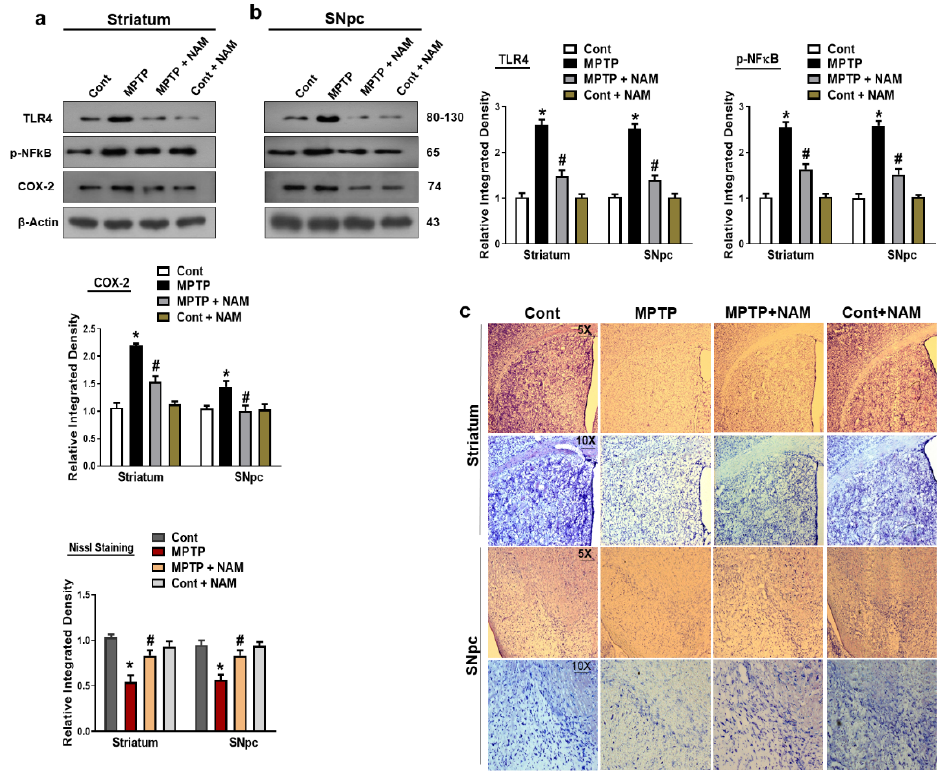
Figure 6. Nicotinamide (NAM) regulated the expression of inflammatory markers. ( a , b ) Images of the scanned immunoblot results and their graphical representation of the expression Toll-like receptor 4 (TLR-4), phosphorylated nuclear factor- κ B (p-NF κ B), and cyclooxygenase-2 (COX-2) in the striatum and SNpc of the different experimental groups. β -actin was used as a loading control; ( c ) Images of the Nissl staining of the striatum and substantia nigra of different experimental groups captured with different magnifications (5 × and 10 × ), respectively. The values are expressed as the mean ± SD for indicated proteins ( n = 10 mice/group), and the number of independent experiments was n = 3. * Significantly different from the control group, # Significantly different from the MPTP-treated group. Significance: * p < 0.05; # p < 0.05.